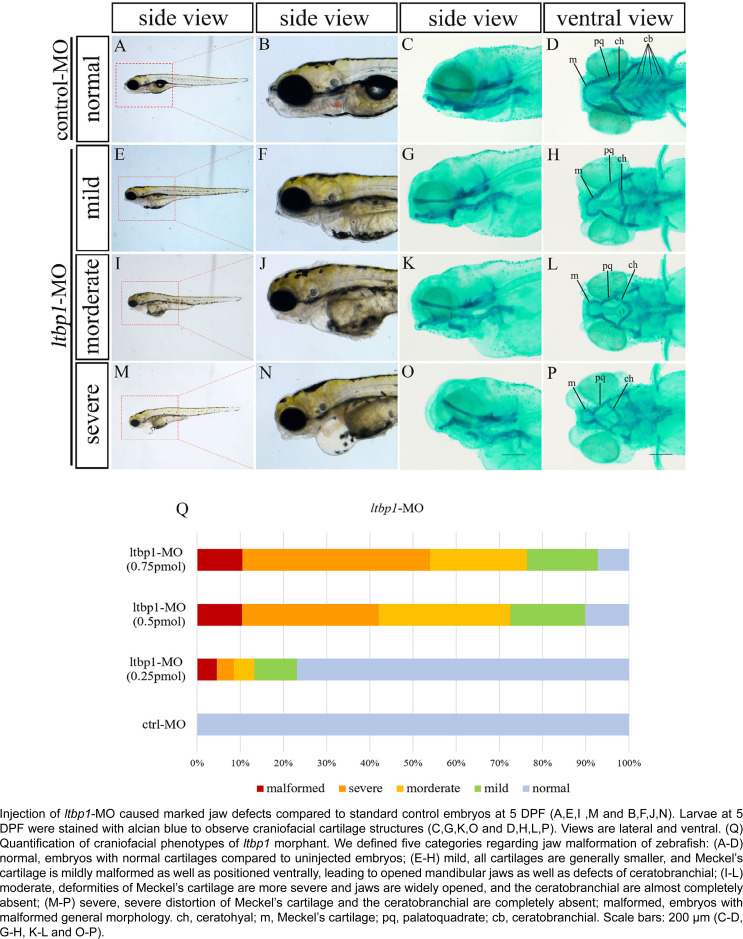
Depletion of ltbp1 causes severe jaw malformation in zebrafish